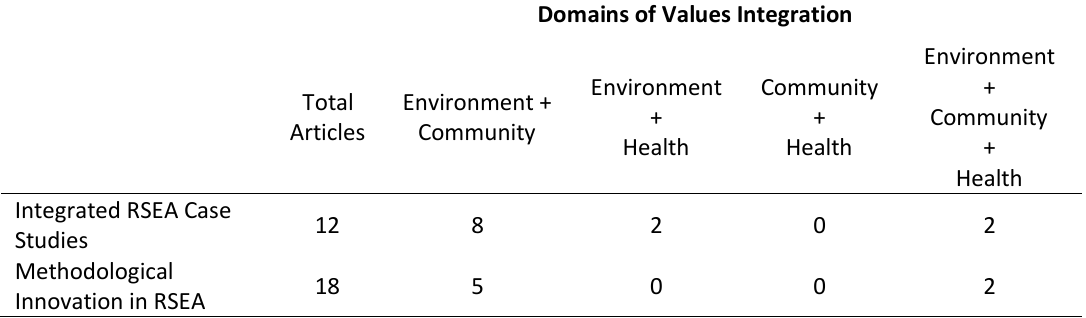
Table 2. Domains of integration among a review of peer-reviewed articles focused on integrated RSEA (N=30) Domains of Values